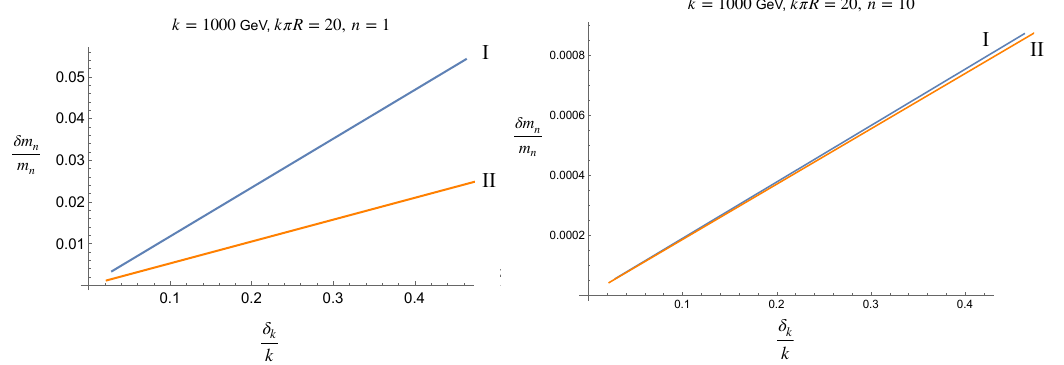
Figure 4 . Relative mass splitting as a function of the fractional change δ K /k for the KK levels (a) n = 1 and (b) n = 10